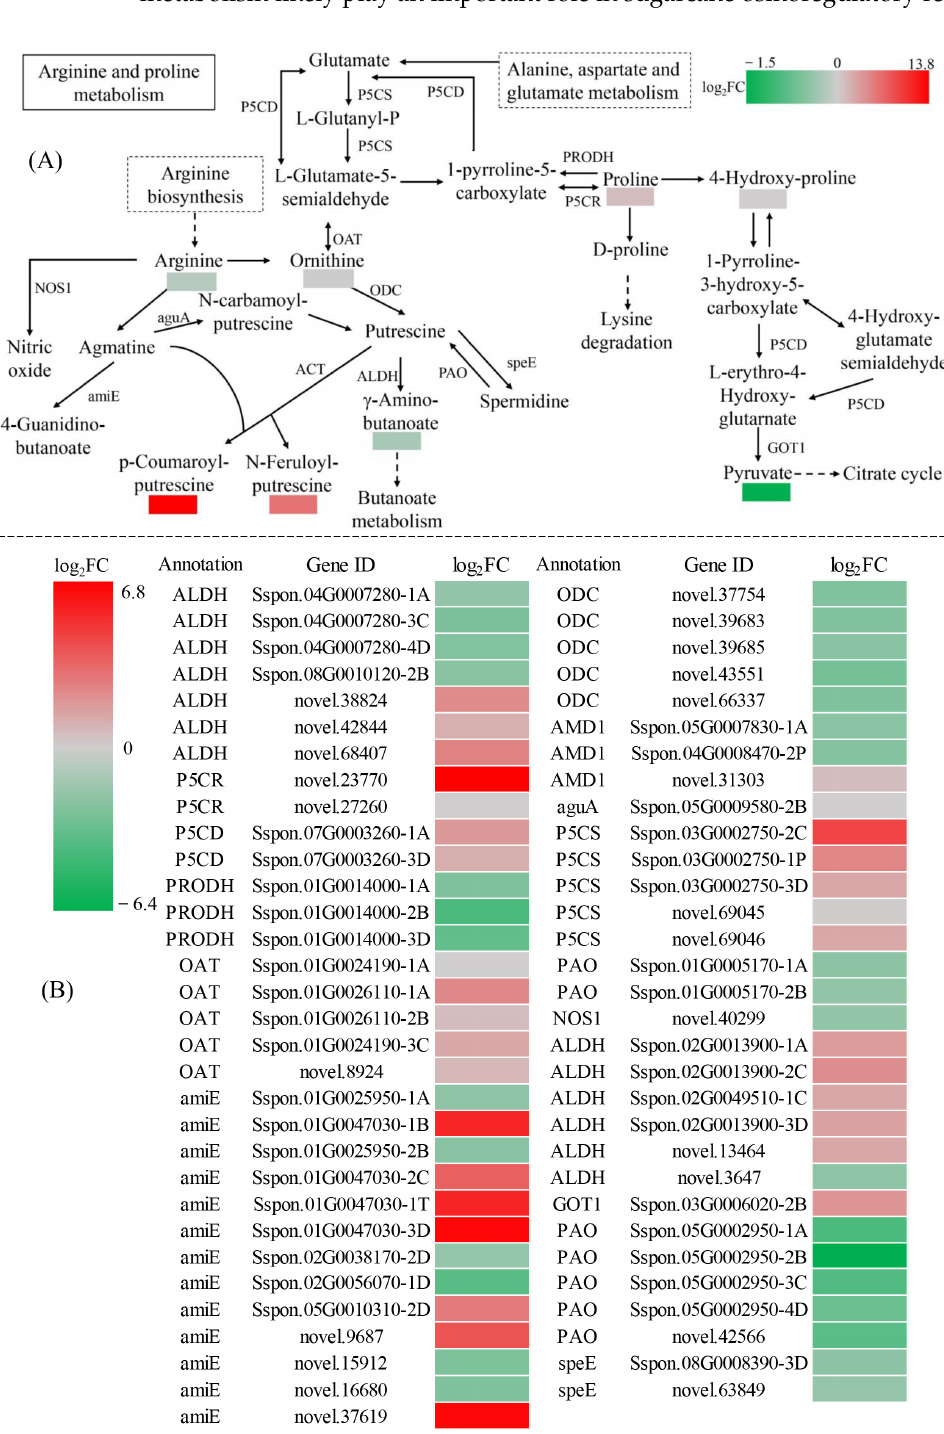
Figure 10. Analysis of DEGs and SRMs in the arginine and proline metabolism pathway. ( A ) Enriched SRMs for the CG/DS groups. ( B ) Enriched DEGs for the CG/DS groups. |log 2 FC| denotes |log 2 Fold Change|. Solid line stands for direct reaction. Dashed line stands for indirect reaction, which means it have to go through multiple reactions.